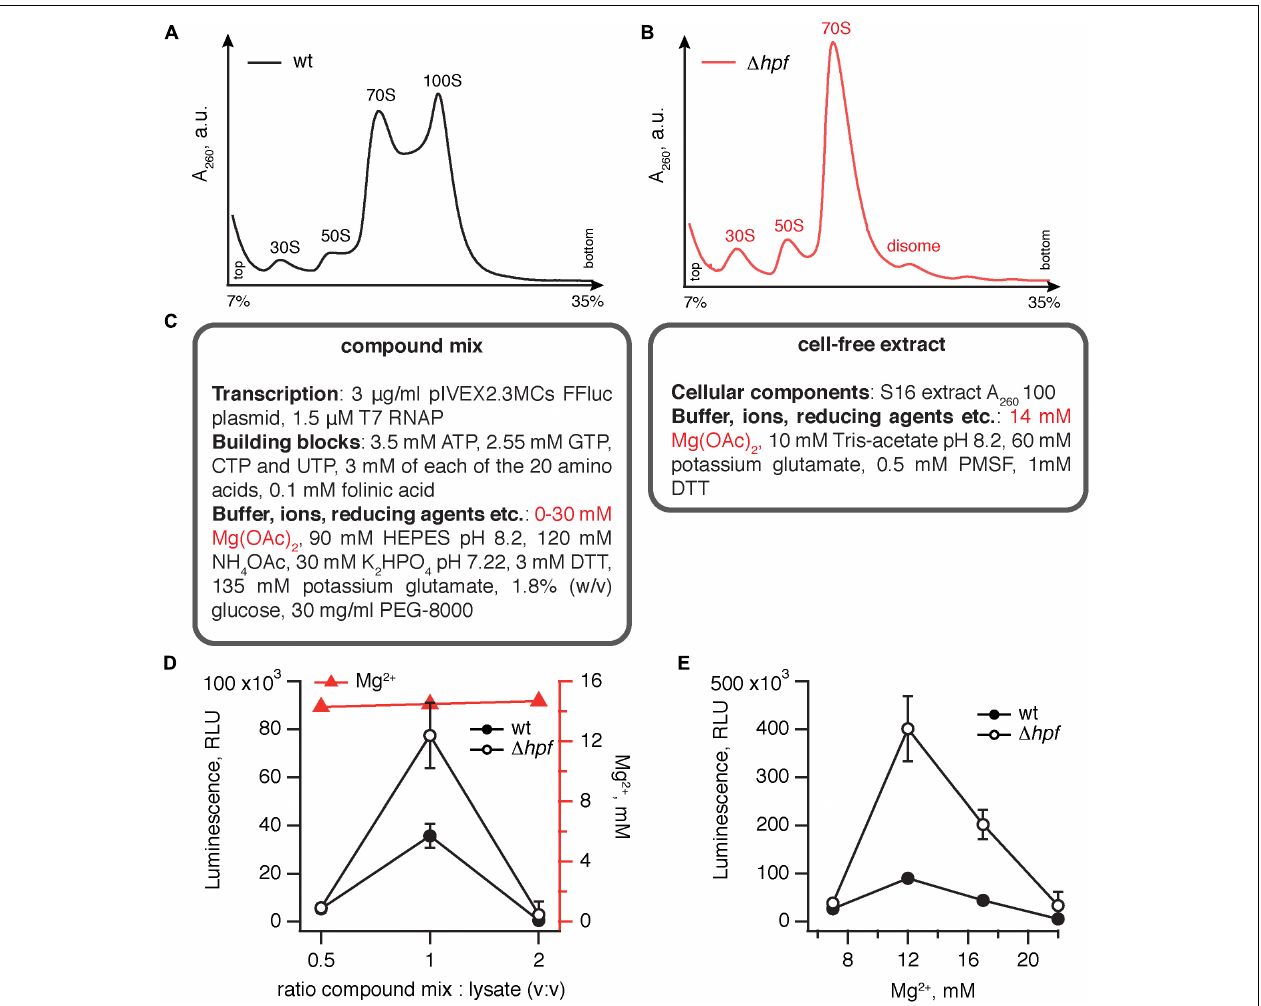
FIGURE 1 | Elimination of HPF improves the efficiency of B. subtilis coupled transcription-translation system. Polysome profile analysis of translational lysates prepared from wild type (A) and (cid:49) hpf (B) lysates demonstrates strictly HPF-dependent 100S ribosomes formation. (C) A cell-free translation system was assembled by combining the compound mix with the cell-free extract. The efficiency of translation was quantified by the activity of the firefly luciferase using the Steady-Glo Luciferase Assay (Promega). Titrations of the compound mix to cell-free extract ratio (D) and magnesium ion concentration (E) in the cell-free translation system. Luminescence readings were taken after incubation for 1 h at 37 ◦ C. Error bars indicate the standard error of the geometric mean of biological replicates, i.e., independently prepared cell-free extracts ( n ≥